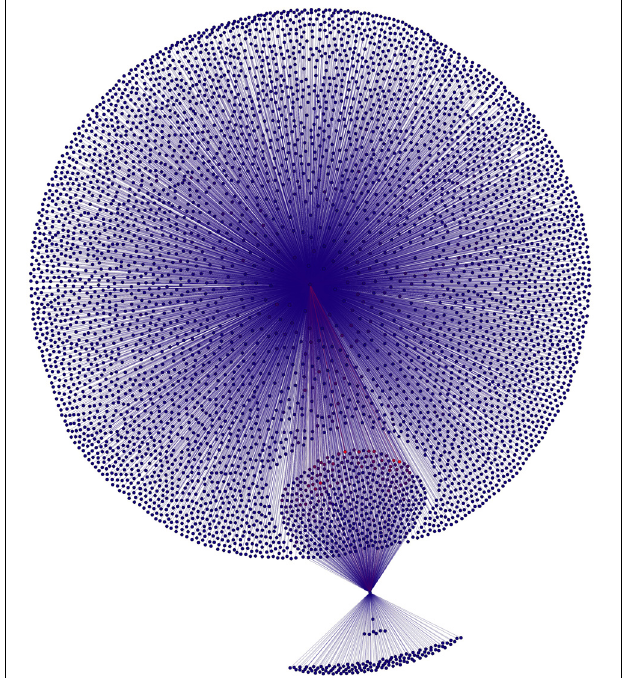
FIGURE 1 | First-order associates of grumpy - cat. Connectivity between associates is not displayed. The large cloud of nodes are the associates of cat that are not also connected to grumpy ; the small cloud of nodes are the associates of grumpy that are not also connected to cat ; and the round blob between them is the set of nodes that is connected to both grumpy and cat . Figure produced using Force Atlas and Yifan-Hu layout algorithms in Gephi (Bastian et al.,